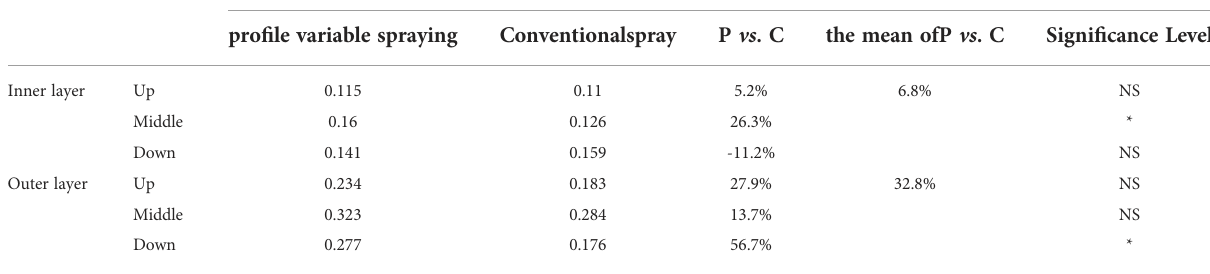
TABLE 3 Droplet coverage results using the pro fi le variable spraying and conventional spraying.